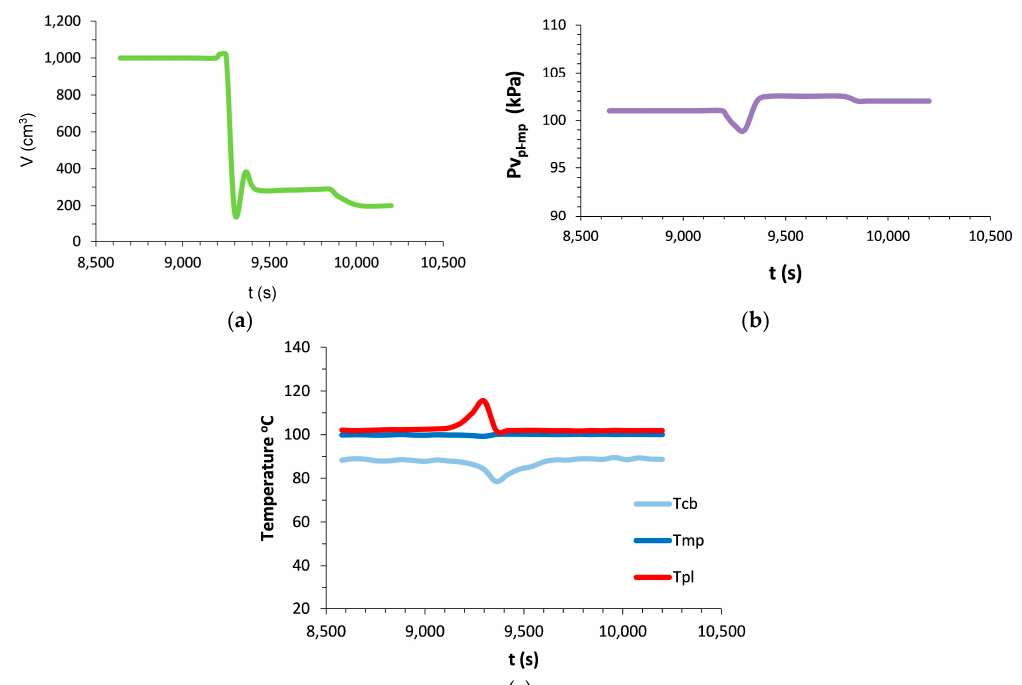
Figure 18. ( a ) Volume of liquid displaced to the tray ( V dt ); ( b ) Effective vapor pressure at the plate- porous medium interface ( Pv pl-mp ); ( c ) Surface temperature of the plate ( T pl ), temperature of the porous